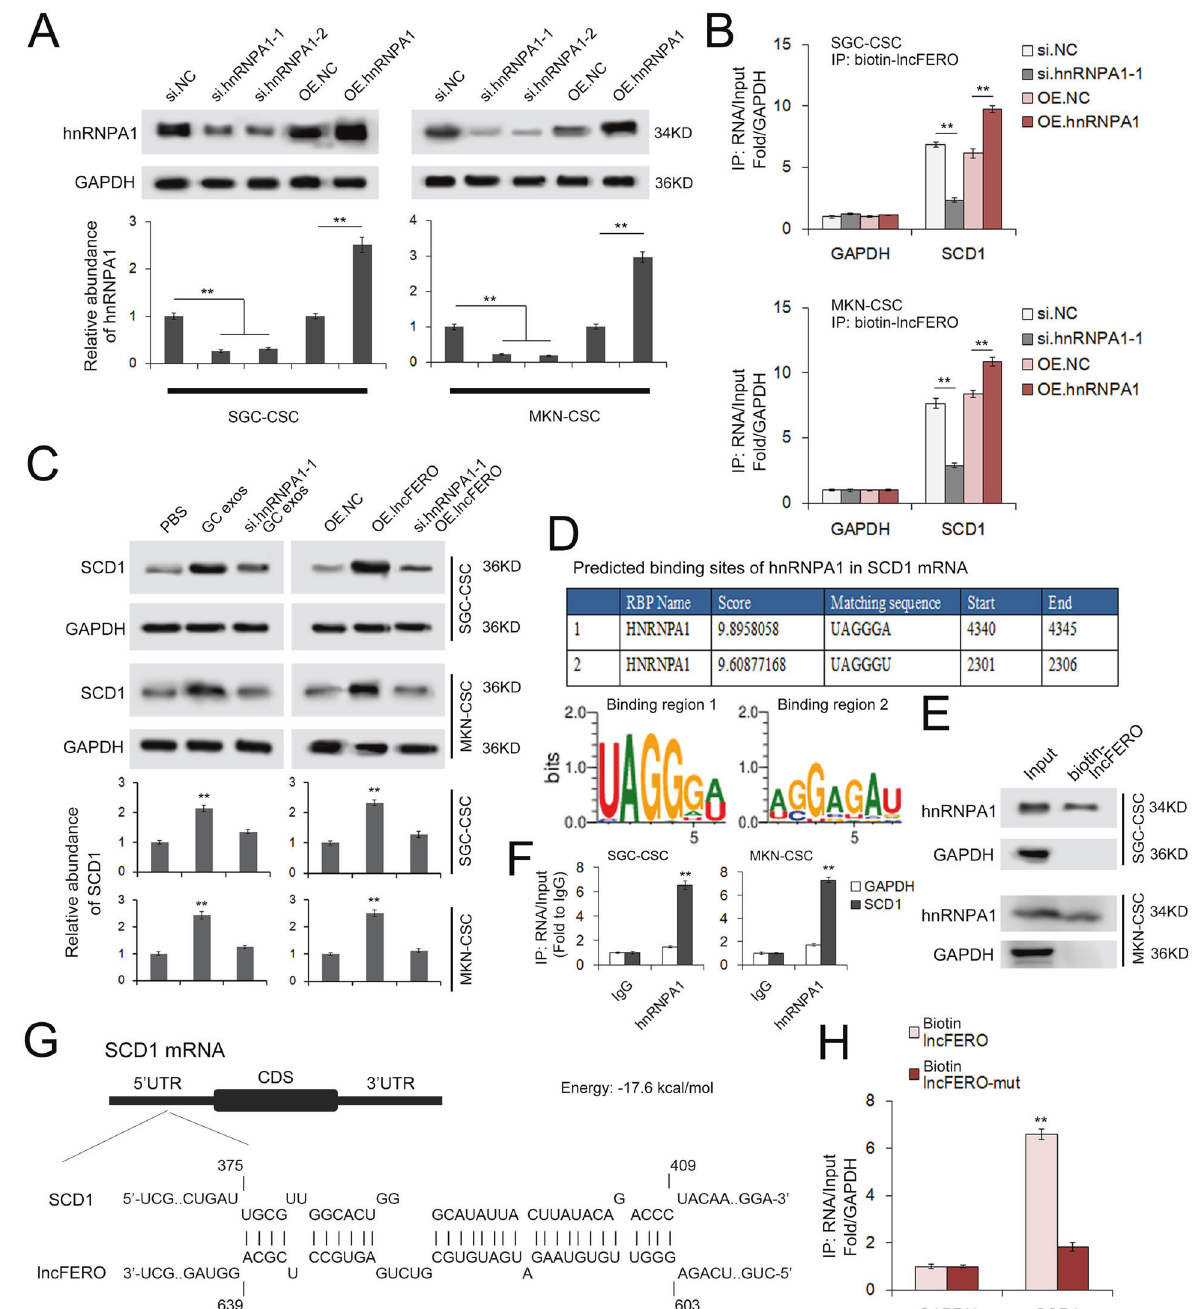
Fig. 6 LncFERO interacts with SCD1 mRNA and promotes SCD1 translation by recruiting hnRNPA1. A hnRNPA1 in GCSCs was overexpressed or knocked down ( n = 3). B hnRNPA1 stabilizes the interaction between lncFERO and SCD1 mRNA ( n = 3). C GC exosomal lncFERO depends on hnRNPA1 to promote SCD1 expression in GCSCs ( n = 3). D RBPDB analysis of the speci fi c interaction between hnRNPA1 and SCD1. E Detection of hnRNPA1 protein in the samples derived from lncFERO pulldowns performed in GCSCs ( n = 3). F RIP shows the direct interaction between SCD1 mRNA and hnRNPA1 in GCSCs ( n = 3). G Predicted binding sites of lncFERO in the 5 ’ UTR of SCD1 mRNA. H Capture of SCD1 mRNA by biotin-labeled lncFERO ( n = 3). ** p < 0.01.